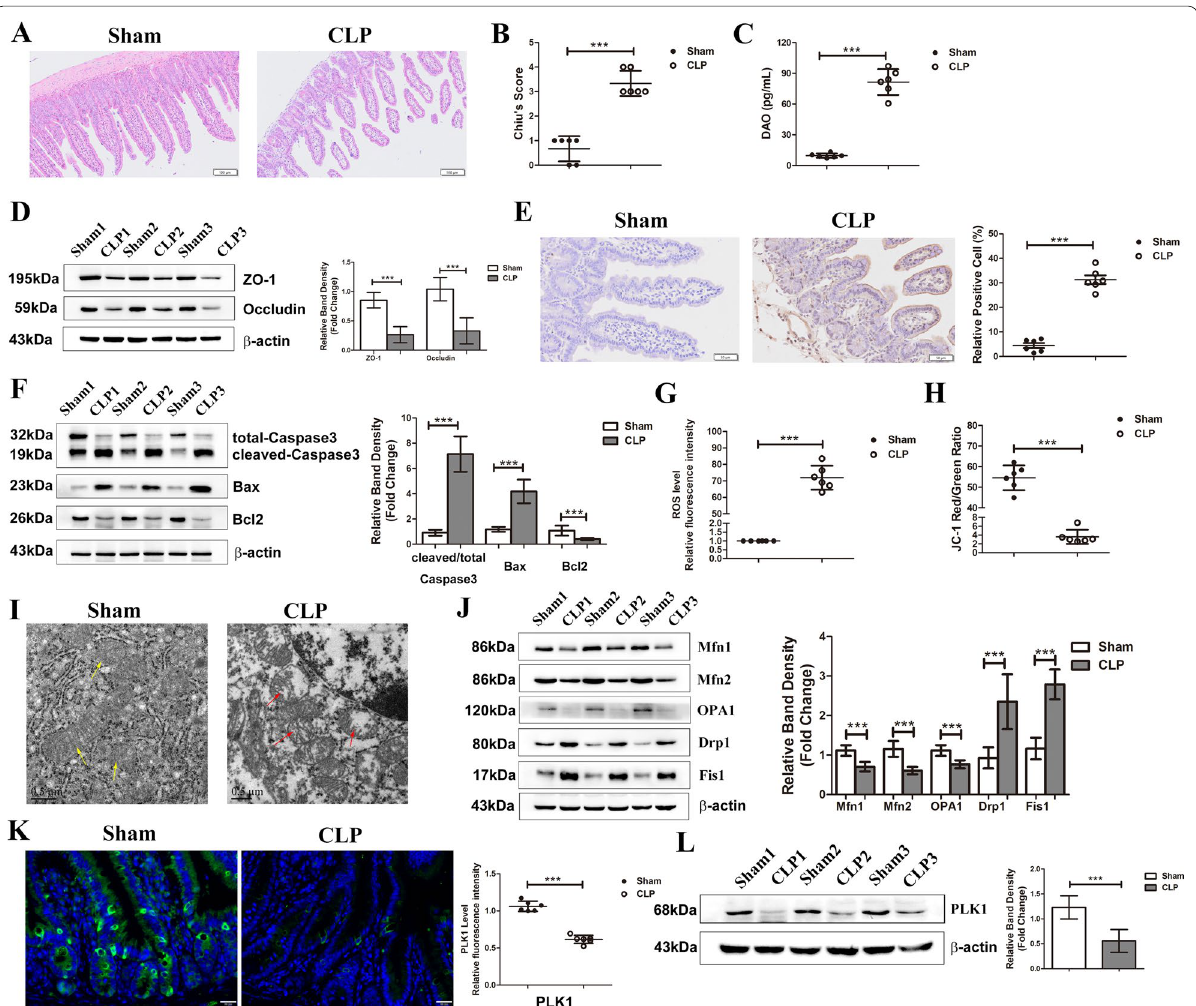
Fig. 1 Sepsis induces intestinal injury and reduces PLK1 expression in the intestinal epithelium. The mice were sacrificed 24 h after CLP and then analysed. A Microphotographs of hematoxylin and eosin (H&E) stained sections of intestine. Scale bar indicates 100 μm. B The Chiu’s scores of each group. C The serum concentration of DAO for each group. D The levels of ZO‑1 and Occludin were analyzed with Western blot. The graph shows the relative band densities. E Representative images of TUNEL staining. The right graph represented the percentage of positive TUNEL stained cell. Scale bar indicates 50 μm. F The levels of apoptotic markers in intestine 24 h after CLP were measured. The right graph shows the relative band densities. G The relative fluorescence intensity of ROS in the intestine. H The ratio of JC‑1 red/green fluorescence intensity which reflecting the MMP level was shown in graph. I Morphological alterations in mitochondria were examined by TEM (scale bar 0.5 μm). Yellow arrows indicate the relatively = normal mitochondrial shape in the sham group. Red arrows denote deformed mitochondria with the loss of clearly defined cristae. J Representative Western blots showing mitochondrial fusion (Mfn1, Mfn2, OPA1) and fission (Drp1 and Fis1) markers on the left, and the graph on the right shows the relative band densities. K Representative PLK1 immunohistochemical staining in the intestine (scale bar 20 μm). The graph shows the relative = fluorescence intensity. L Representative Western blots presents the expression of PLK1 in intestine and the graph on the right shows the relative band densities. The data in the graphs are expressed as the mean SD. *** P < 0.001 versus the control group (n ± =